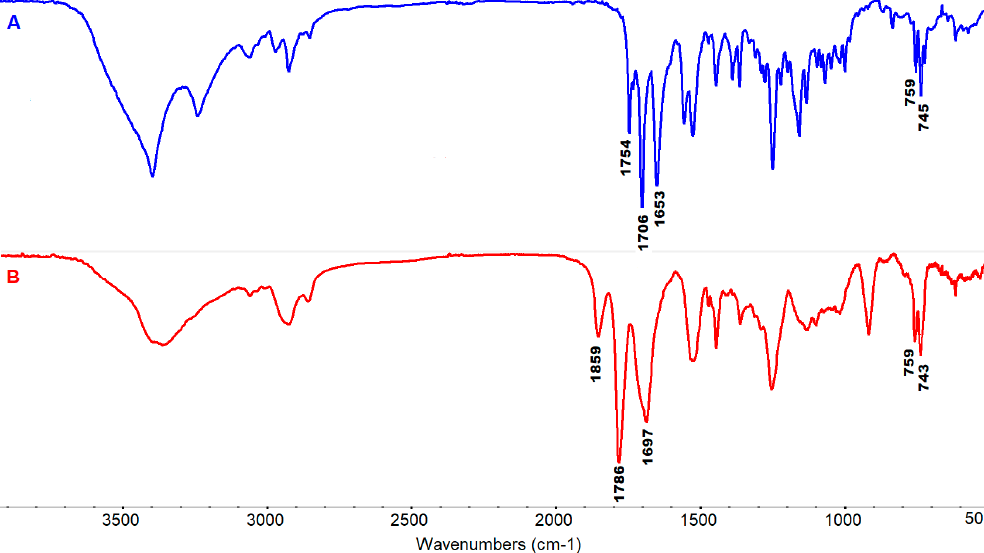
Figure 1. Fourier Transform-Infrared (FT-IR) spectra of: ( A ) N ε -Fmoc- N α -Boc- L -Lysine precursor compound; and, ( B ) the final pure N ε -Fmoc- L -Lysine NCA.